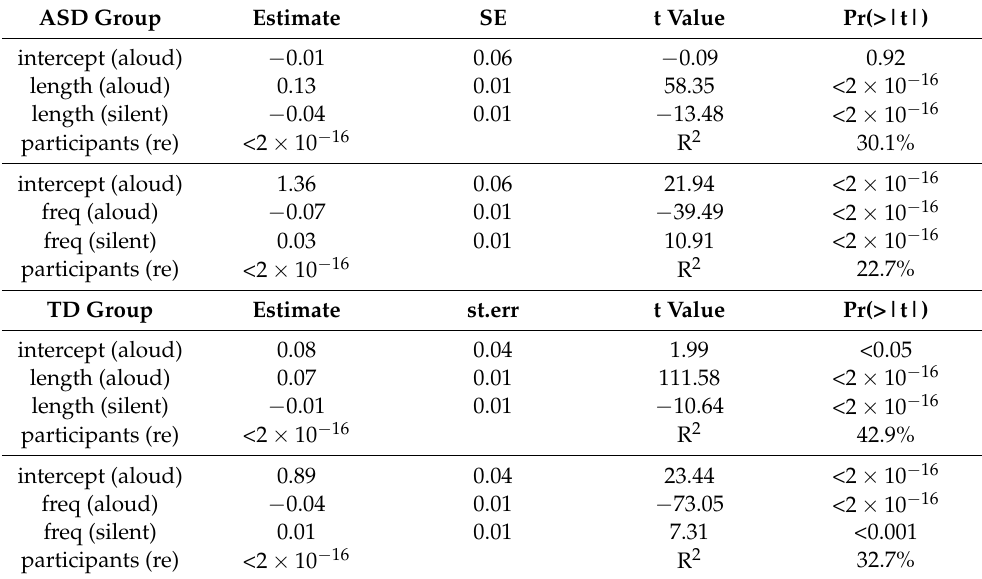
Table 4. GAM coefficients for models fitting tracking time as a function of word length ( length ) or (log)frequency ( freq ) and reading modalities for the two experimental groups. In the two models, participants are added as random effects ( re